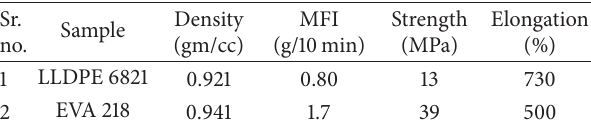
Table 1: Important physical parameters of polymer resins used in this